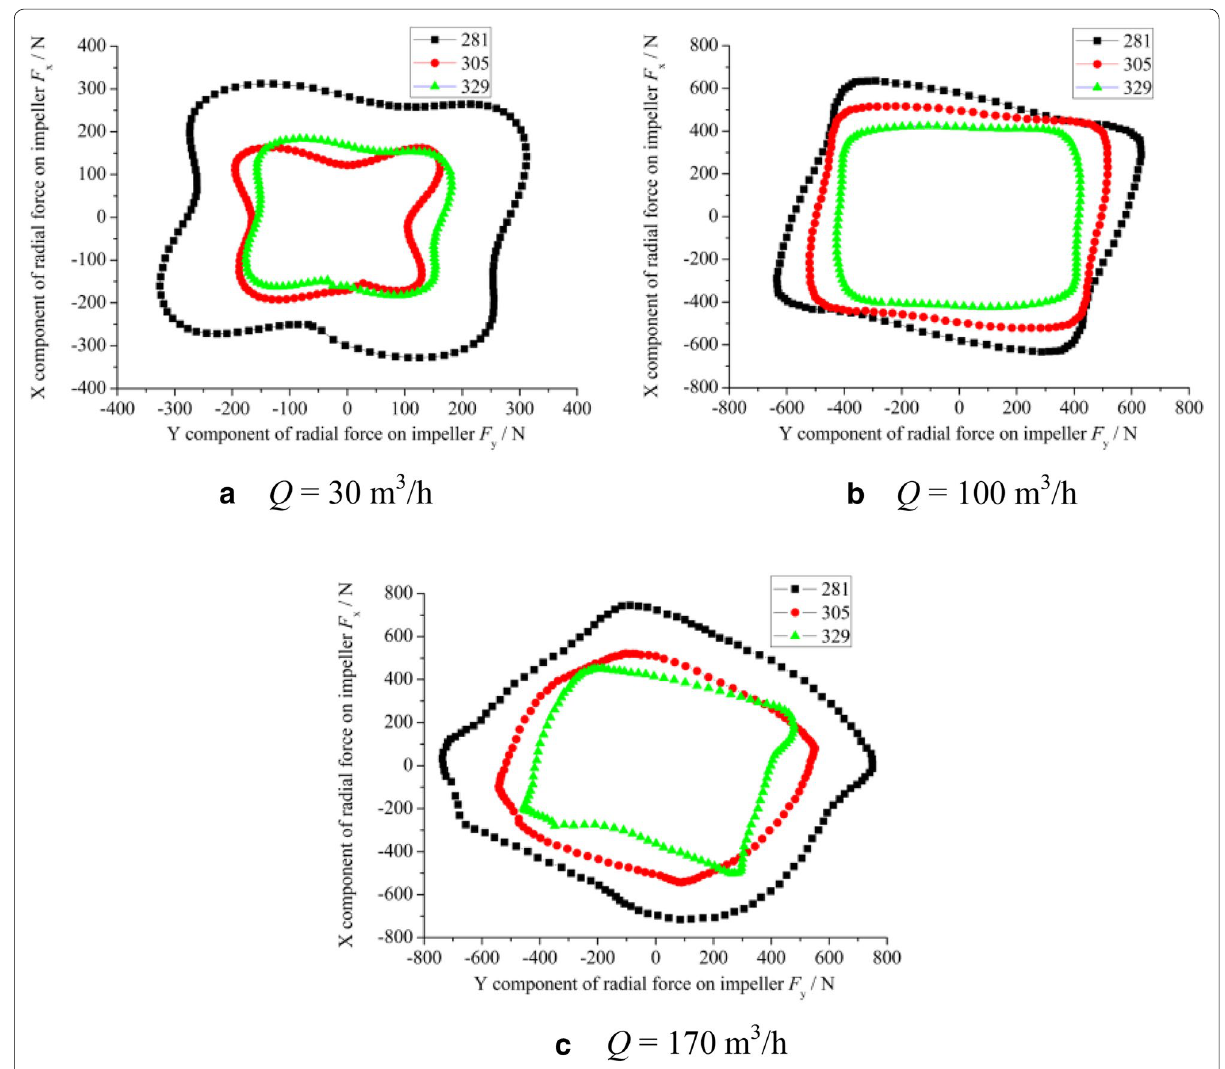
Figure 15 Radial force on shaft for three cases with flow rate